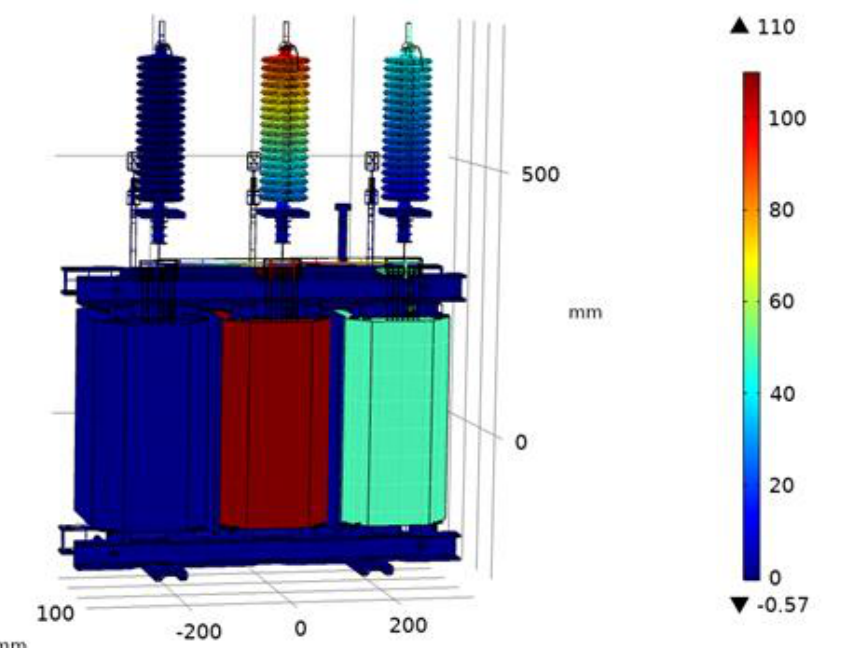
Figure 13. Peak surface electric potentials during lightning impulse.